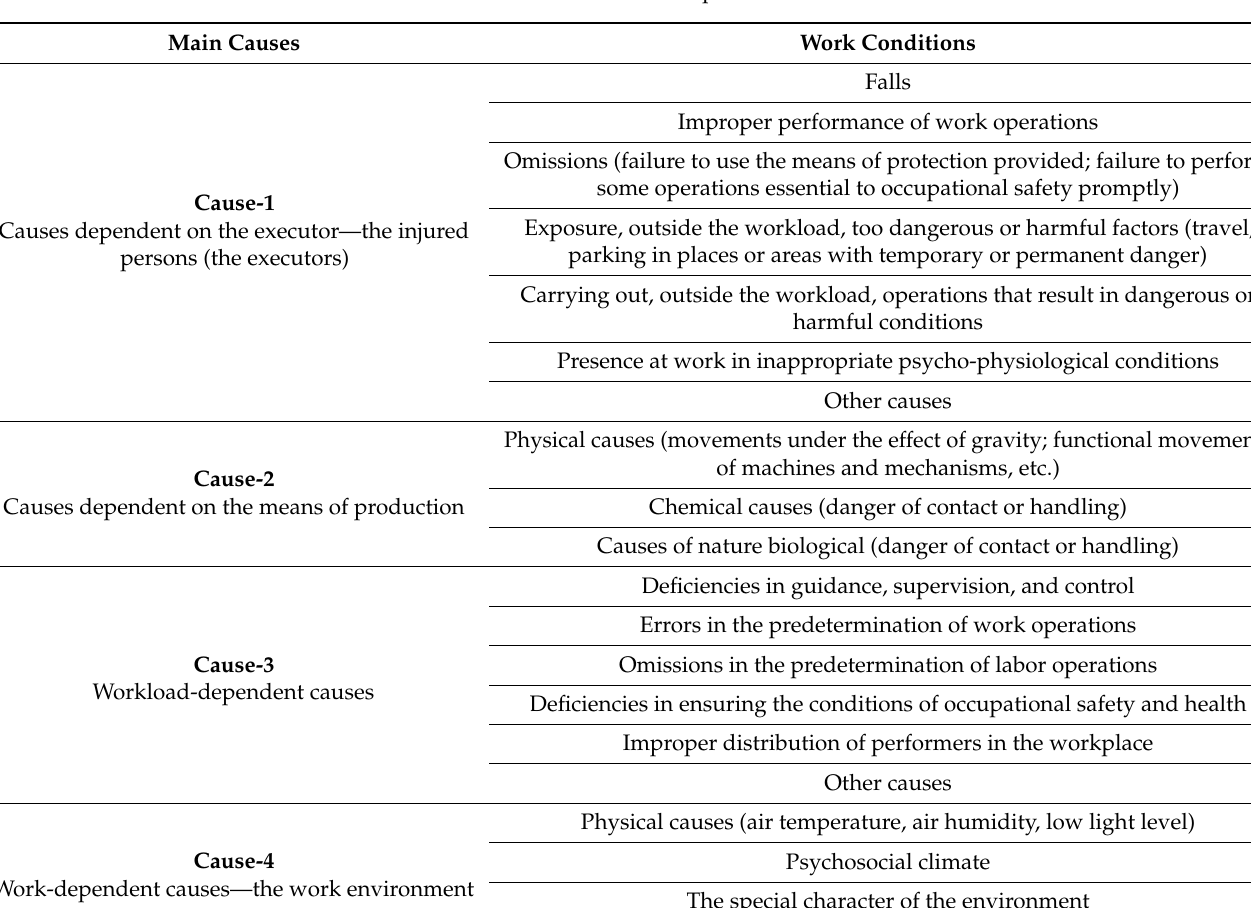
Figure 1. Conceptual framework. Table 1. Data